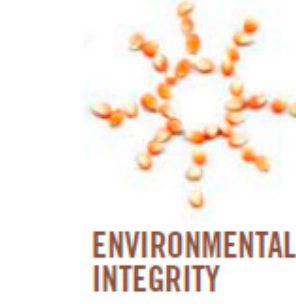
Figure 3. According to the Sustainability Assessment of Food and Agriculture systems (SAFA) approach, sustainability assessment depends on these four categories of evaluation. Source: SAFA Guidelines.